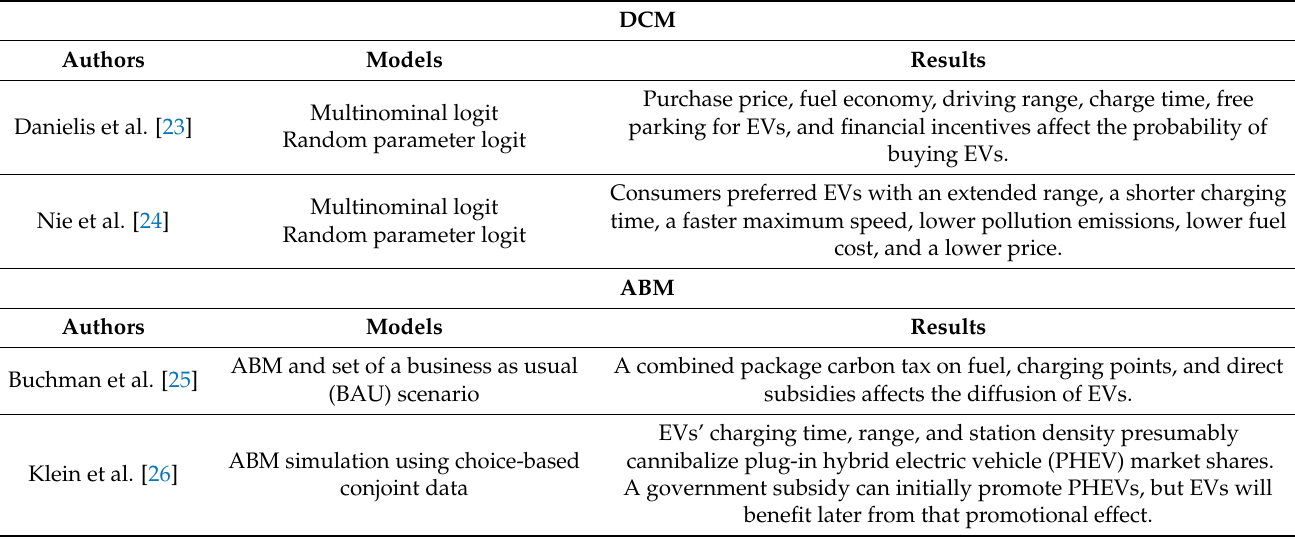
Table 2. Different approaches for the adoption rate